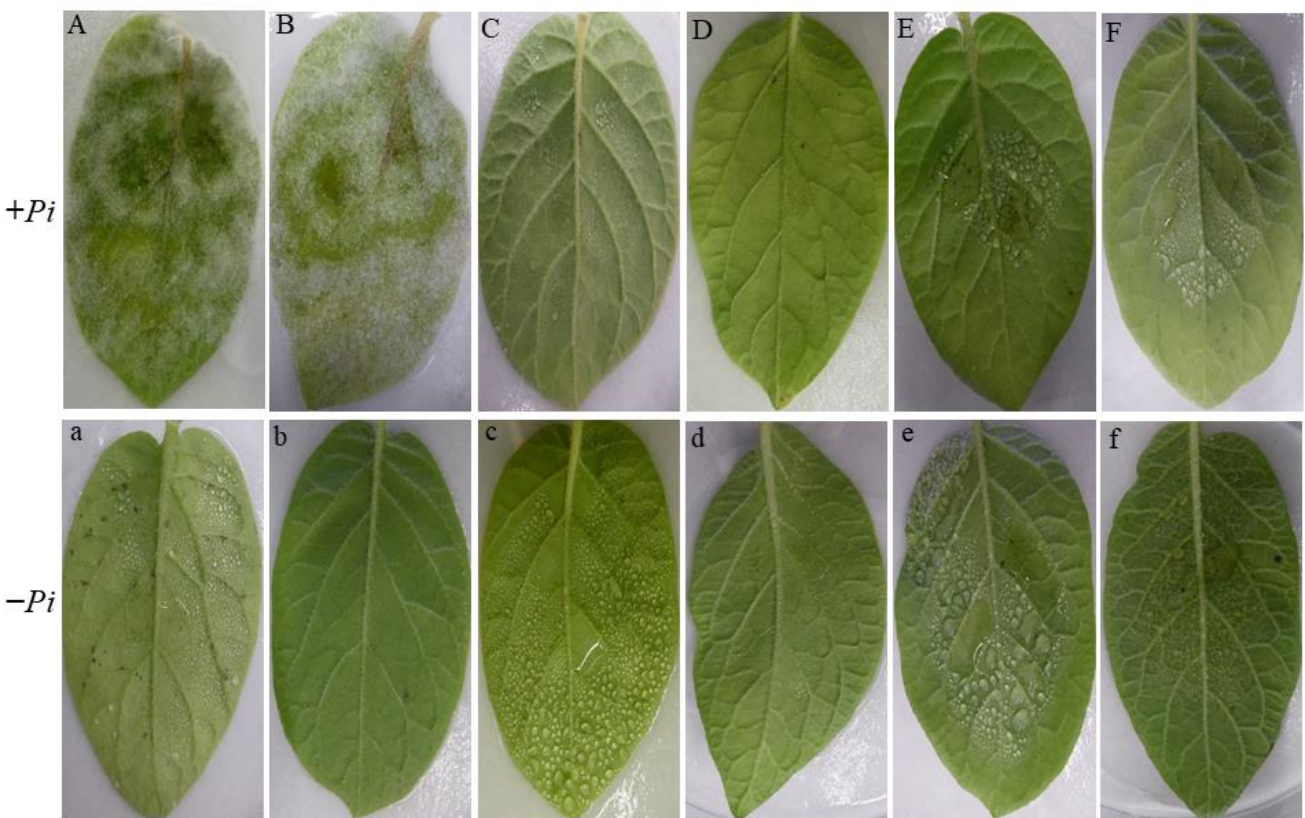
Figure 6. Detached potato leaflets treated or not with crude extracts of the endophytes and inoculated (+ Pi , uppercase latters) or not ( − Pi , lowercase letters) with sporangial suspension of P. infestans . ( A , a ): water control, ( B , b ): solvent control, ( C , c ): Infinito ® , ( D , d ): KB1S1-4, ( E , e ): KB2S1-15, and ( F , f ):